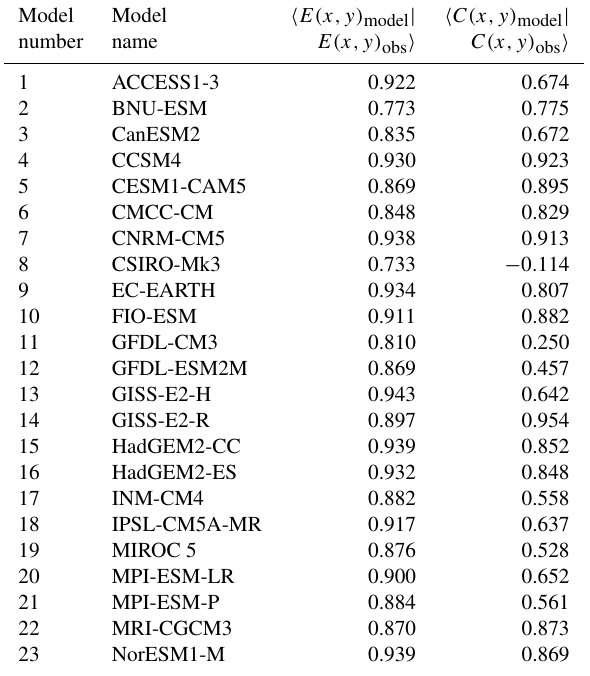
Table 2. Spatial correlation between observed (HadISST) and sim- ulated (CMIP5 models) E and C patterns within the equatorial Pa- cific (120 ◦ E–80 ◦ W; 5 ◦ S–5 ◦ N).